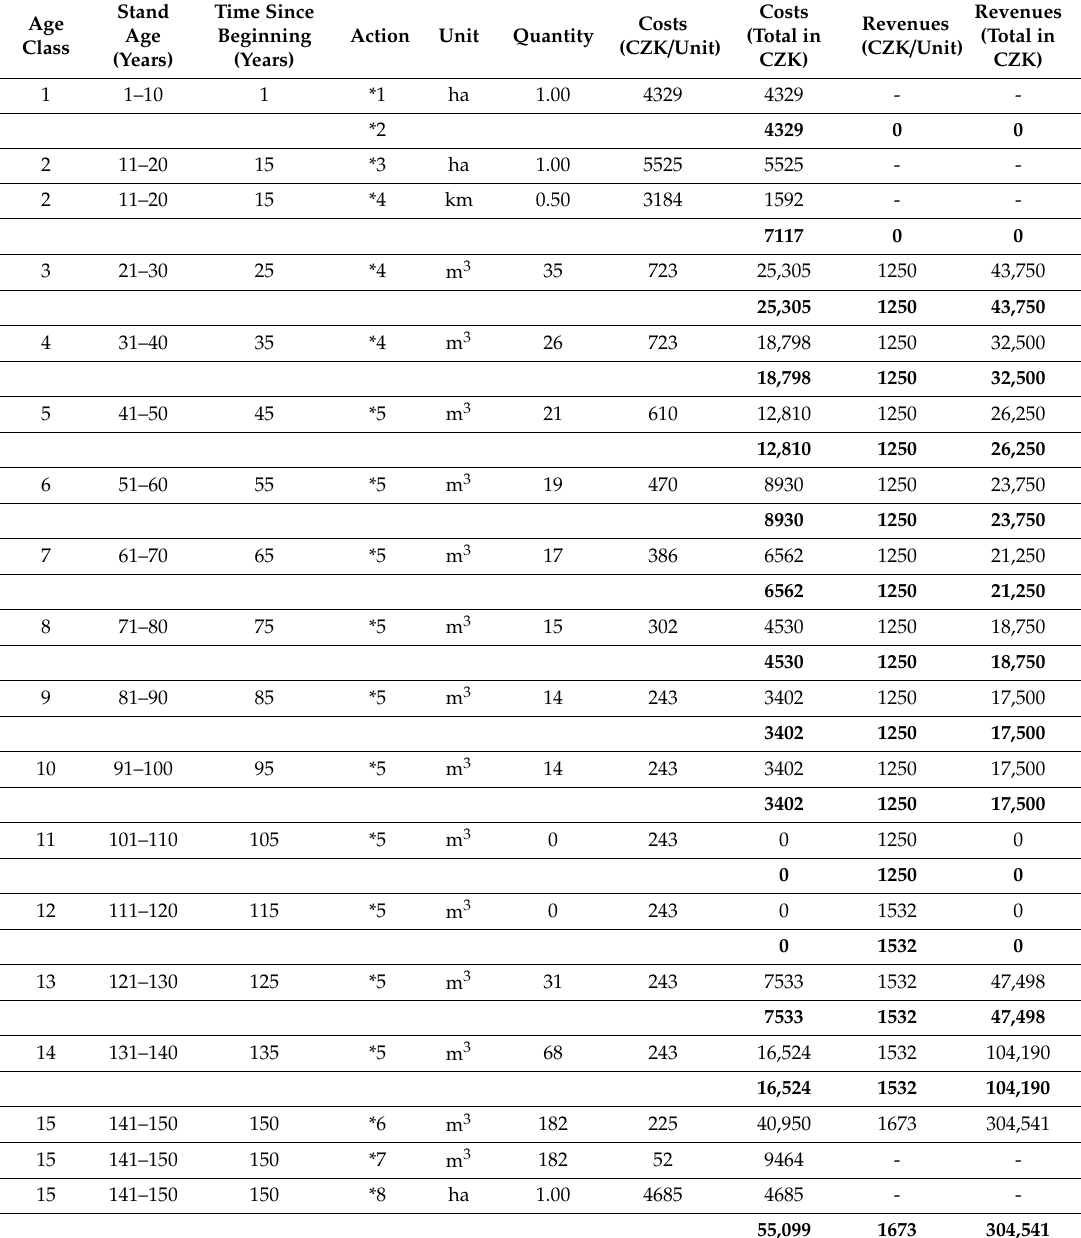
Table 3. Variant: Oak over-mature coppice without game-proof